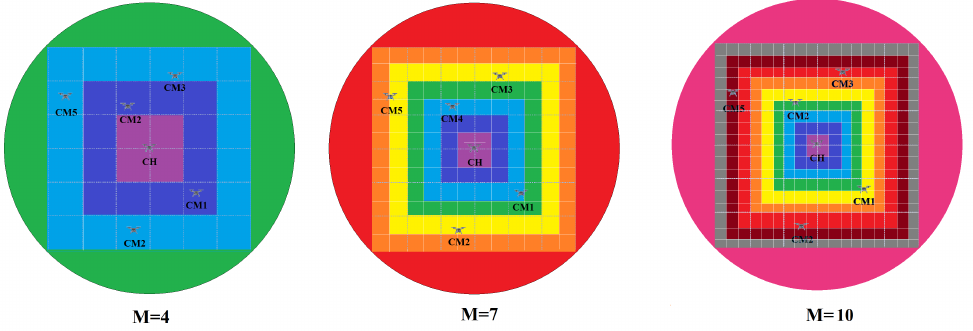
Figure 6. Three different methods of dividing